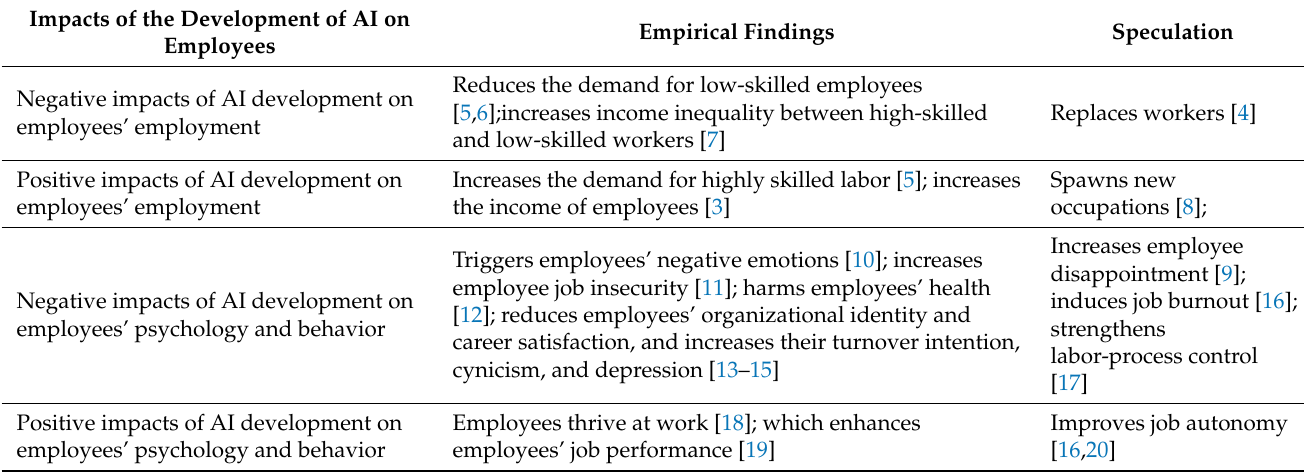
Table 1. Summary of impacts of the development of artificial intelligence on